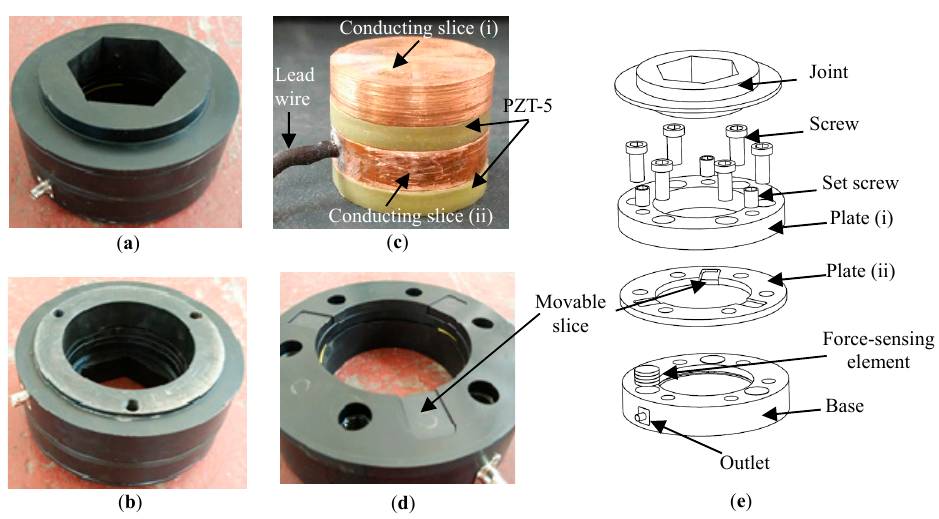
Figure 10. The prototype and the main components of the sensor. ( a ) The front side and ( b ) back side of the piezoelectric sensor; ( c ) The force-sensing element in the sensor; ( d ) The installation state of the movable slices; ( e ) The exploded-views of the sensor.